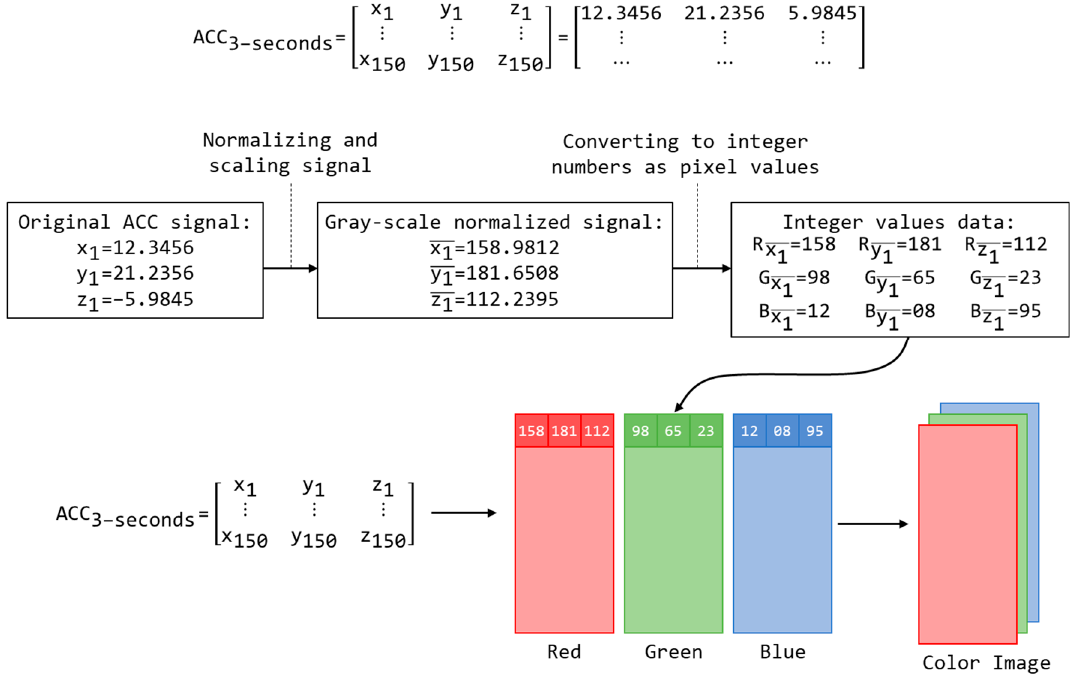
Figure 2. An example of encoding an ACC signal into an image.